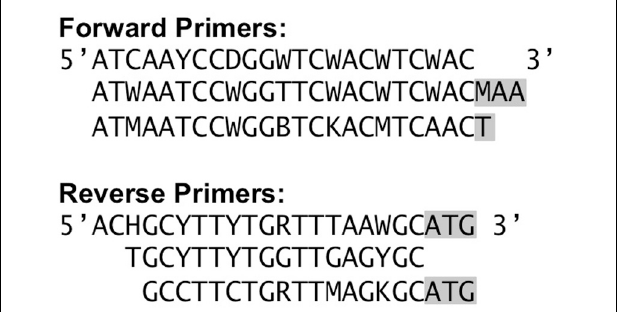
FIGURE 2 | buk amplification primers (Vital et al., 2013). Bases in gray were not used as the primer sequence inputs in the Initial Process in order to capture the same gene region from each read.